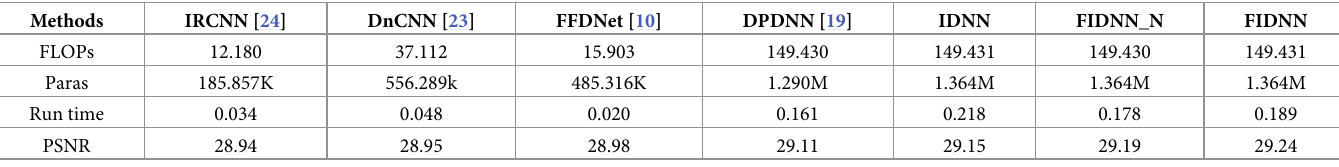
Table 7. FLOPs (in G) and parameters on image size 256 × 256. Runtime (in seconds) of each image and average RSNR (in dB) for noise level 50 on Kodak24 dataset.